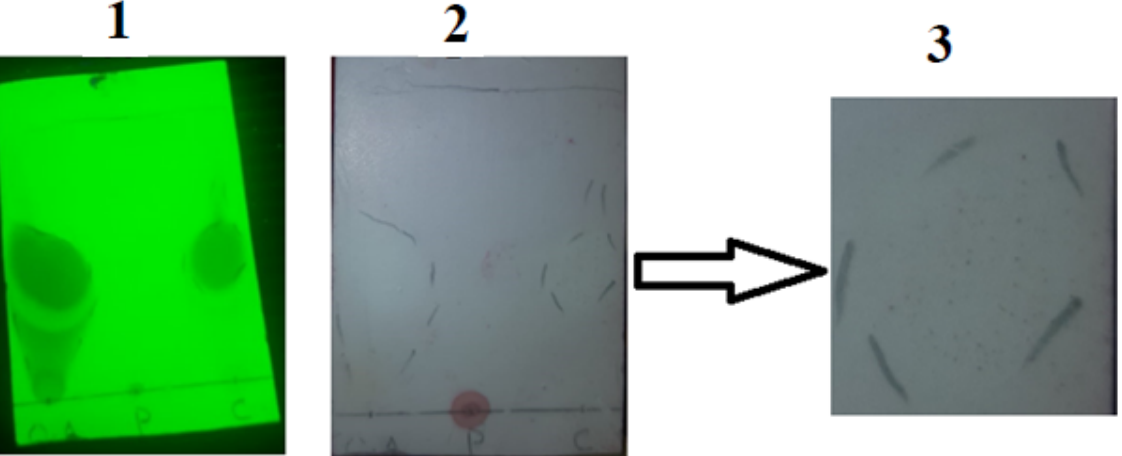
Figure 4. Thin layer chromatography of oleoyl chloride (O), papain (P) and oleoyl chloride-papain conjugate (C). The figure is an illustration view under ultraviolet light (1), a view with the naked eye (2) and a zoom-in of the potential area representing violet spots of immobilized papain (3).